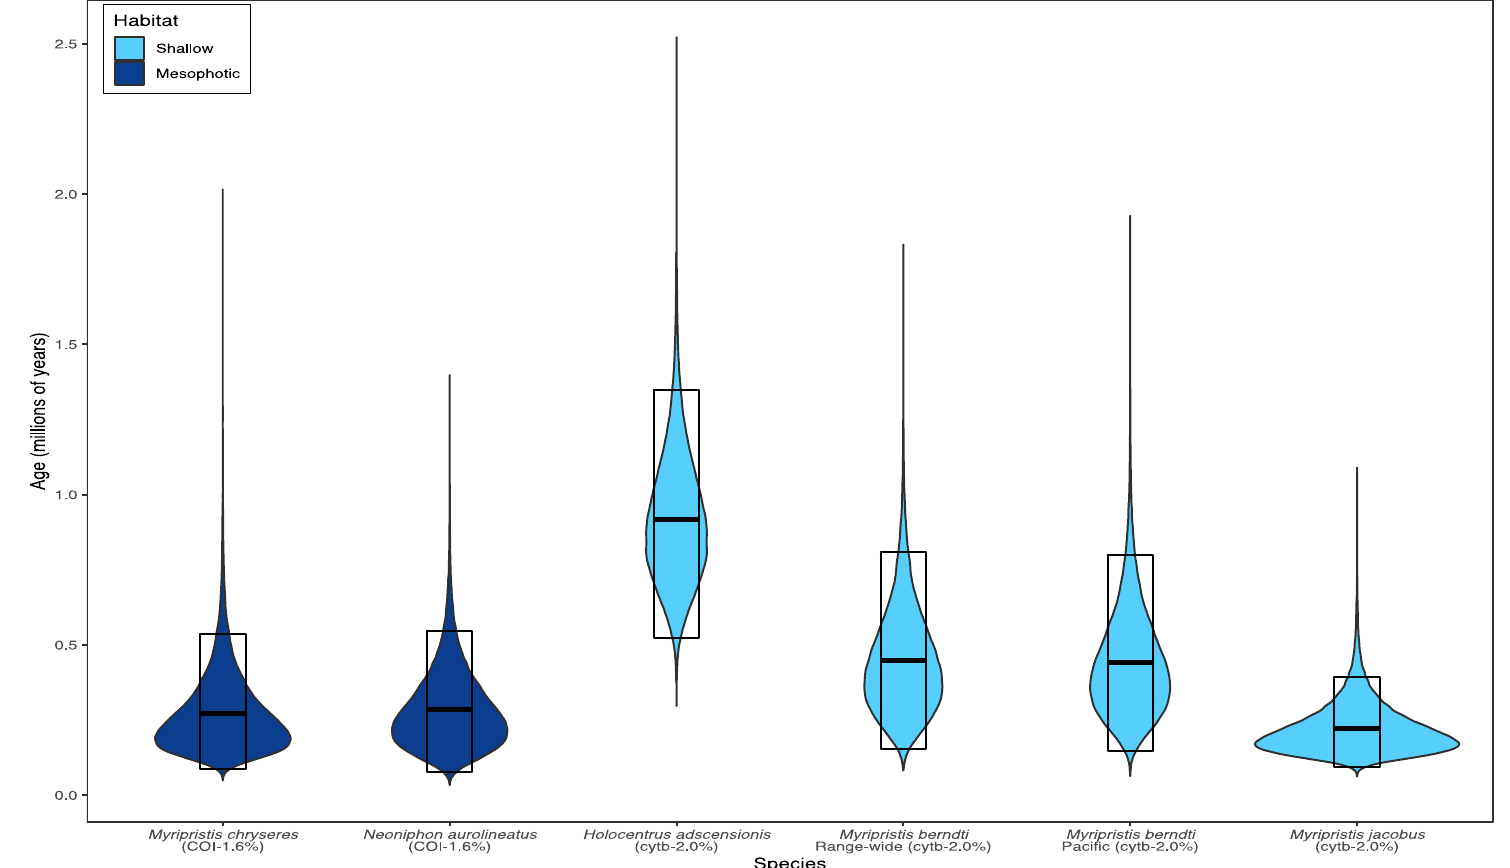
Figure 3. Violin plot comparing coalescence ages of species examined in this study, including Myripristis berndti , M. jacobus , Holocentrus adscensionis (shallow reefs), and M. chryseres and Neoniphon aurolineatus (deep reefs). Boxes indicate mean age (central bar) and 95% highest posterior density (upper and lower box borders). These include two plots for M. berndti : one for the entire Indo-Pacific range of the species, and one for the Pacific range that is comparable to the surveys for the deep-reef species, M. chryseres and N. aurolineatus .